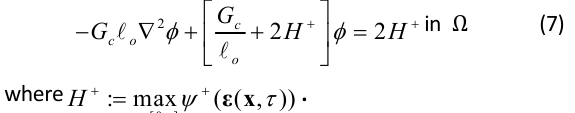
Figure 3. In order to simulate uniaxial tension, the bottom edge is constrained in the y ‐ direction and the right edge is constrained in the x ‐ direction. An incremental uniform the left edge to avoid boundary effects (see Figure 3). The